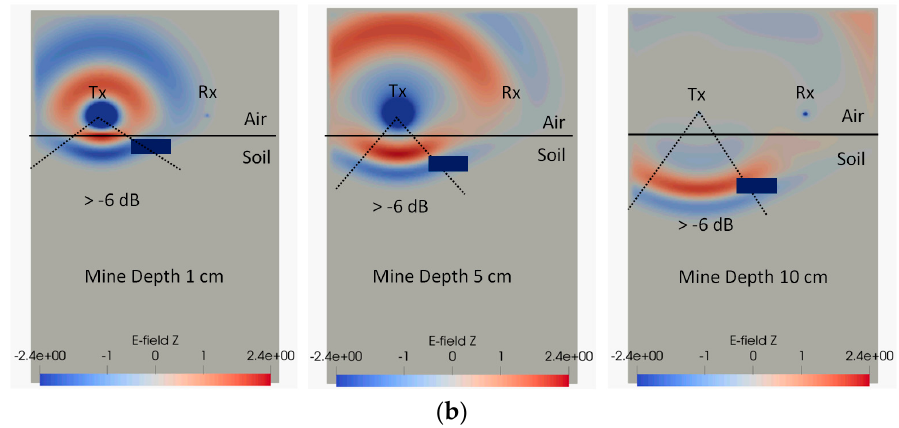
Figure 11. Radiating signal at different depths in loss-less soil (relative permittivity of 8) with 3 cm antenna lift-off height: ( a ) Antenna separation 7 cm; ( b ) Antenna separation 17 cm.